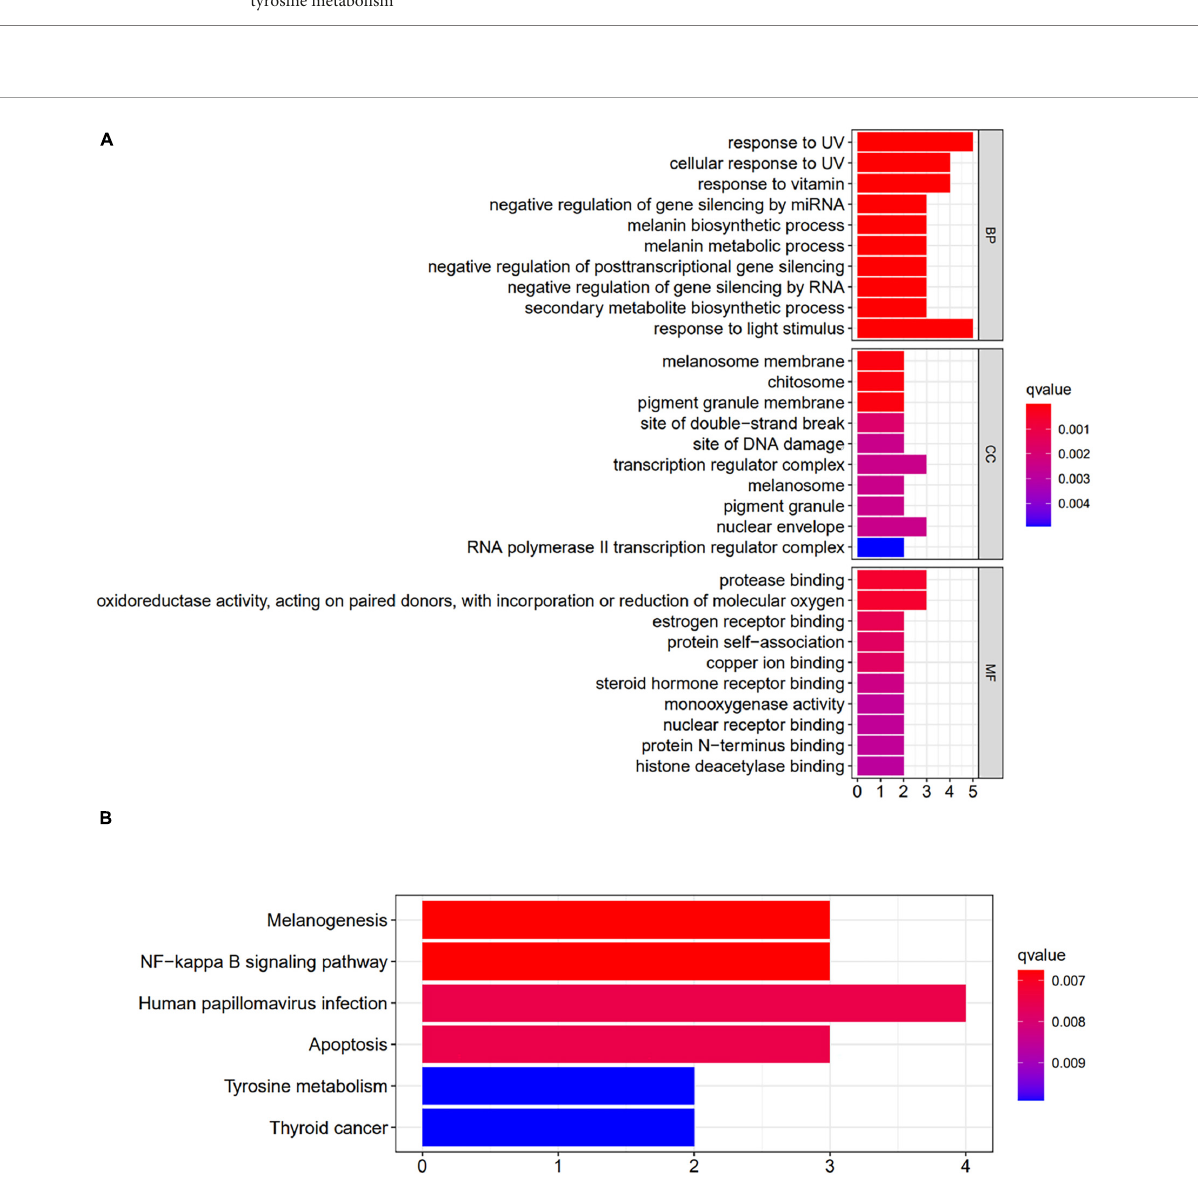
FIGURE10 Enrichment analysis of key genes. (A) Results of GO enrichment analysis. (B) Results of KEGG enrichment analysis. BP, biological process; CC, cellular component; MF, molecular function.